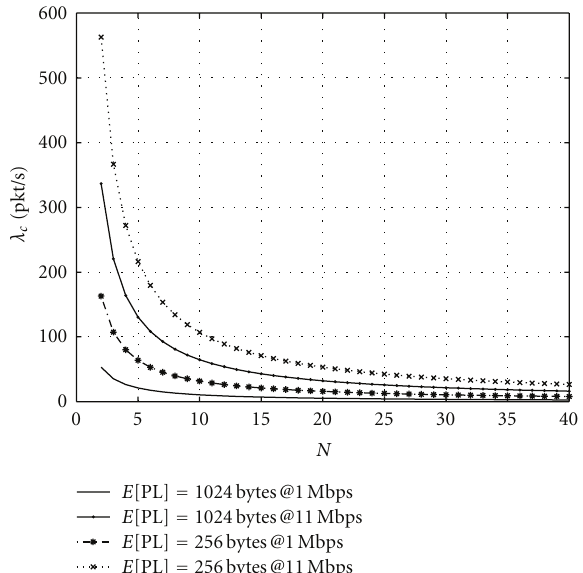
Figure 6: Behavior of λ c in (14) as a function of the packet size E [PL], for two di ff erent values of both N and P e as noticed in the respective legends and for the data rates 1 and 11Mbps. Other parameters are as follows: W 0 = 32 and m = 5. Figure 7: Saturation throughput as a function of the minimum contention window size W 0 , for three di ff erent values of P e and three values of the number of contending stations N as noticed in the legend. The other parameters are as follows: m = 5 and E [PL] = 1024 bytes. The optimal contention window size for each set of parameters is shown in the legend. Continuous curves represent the saturation throughput associated to the case P e = 0, the dashed curves refer to the case P e = 10 − 2 , and the dotted curves are related to the case P e = 10 − 1